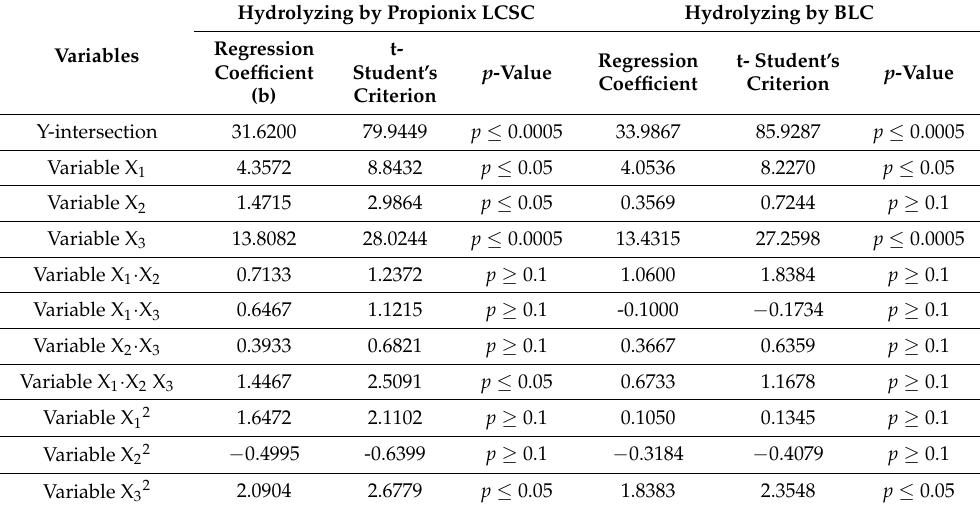
Table 2. Results of statistical analysis of regression coefficients for independent variables (Xj) during hydrolysis of hen